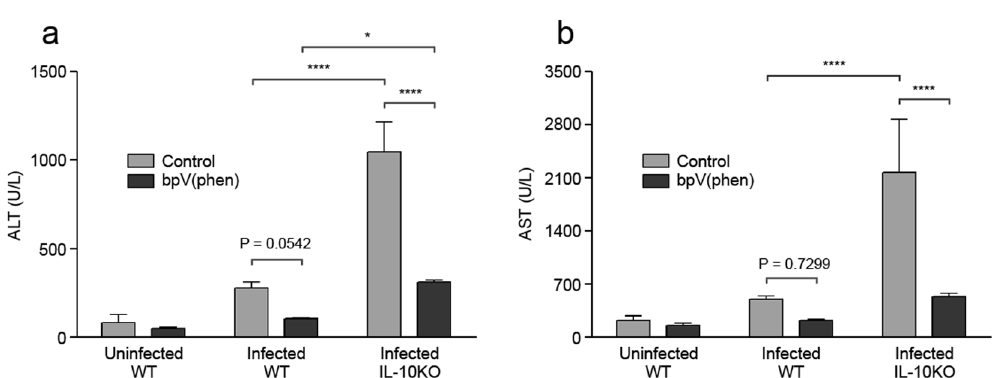
Figure 4. bpV(phen) treatment and IL-10 mitigate ECM-induced liver damage. Serum levels of ( a ) ALT and ( b ) AST measured on day 7 (control WT and IL-10KO mice) and day 10 (bpV(phen)-treated WT and IL-10KO mice) post-infection. n = 5 for control, WT mice, n = 8 for bpV(phen)-treated, WT mice, n = 4 for control, IL- 10KO mice and n = 4 for bpV(phen)-treated, IL-10KO mice. * P < 0.05 and **** P < 0.0001 using a one-way ANOVA and Tukey’s multiple comparisons